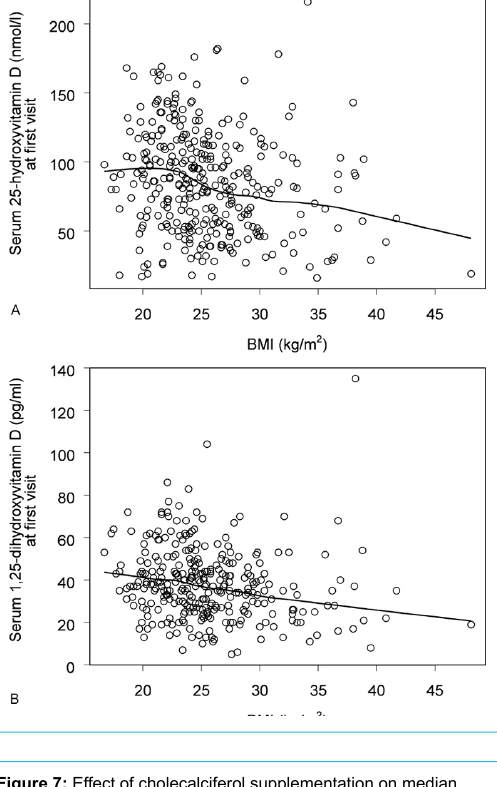
Figure 7: Effect of cholecalciferol supplementation on median 25(OH)D levels. Levels of 25(OH)D were higher in patients under newly started cholecalciferol supplementation and also during con- tinued supplementation, as compared with no